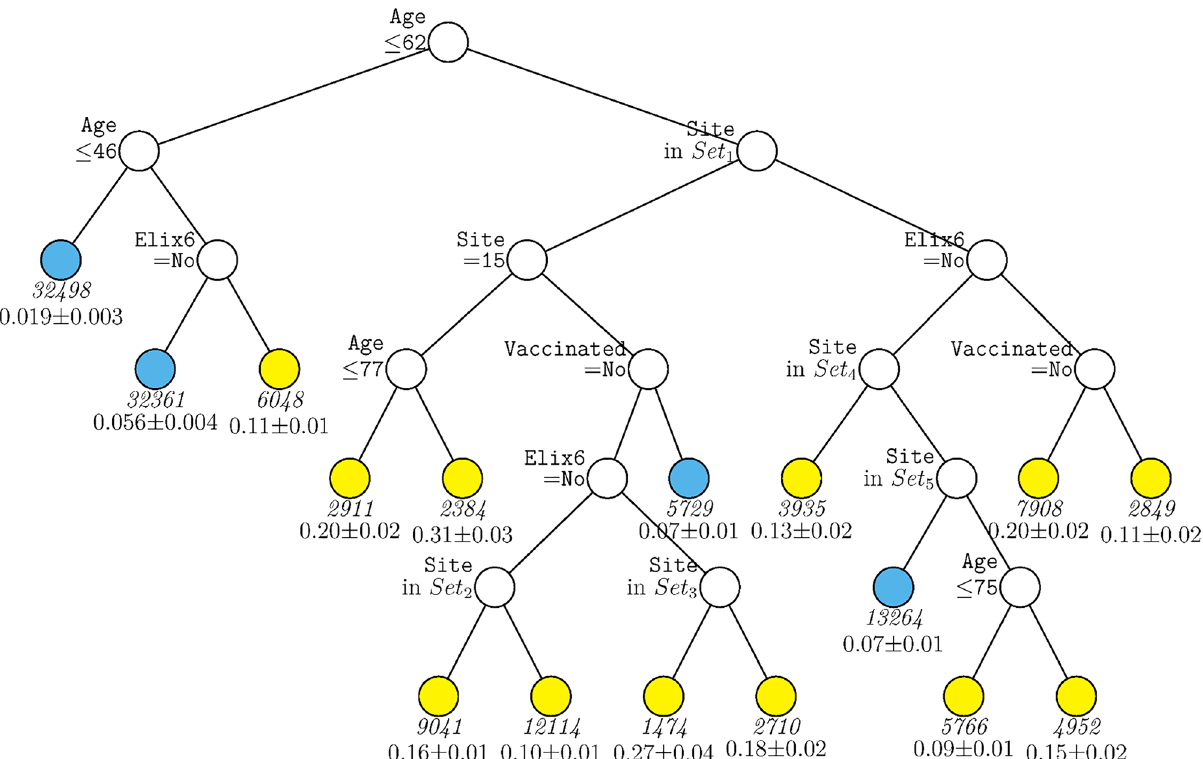
Figure 1. GUIDE subgroup model for differential outcomes for the Full sample. At each split, an observation goes to the left branch if and only if the condition is satisfied. Set 1 = {Site 2, Site 4, Site 5, Site 7, Site 8, Site 13, Site 14, Site 15, Site 18}. Set 2 = {Site 2, Site 5}. Set 3 = {Site 5, Site 13}. Set 4 = {Site 9, Site 16, Site 19}. Set 5 = {Site 1, Site 6, Site 12, Site 17}. Sample sizes (in italics) and 95% simultaneous confidence intervals for mortality rate printed below nodes. Terminal nodes with means above and below overall mortality rate of 0.089 are colored yellow and skyblue